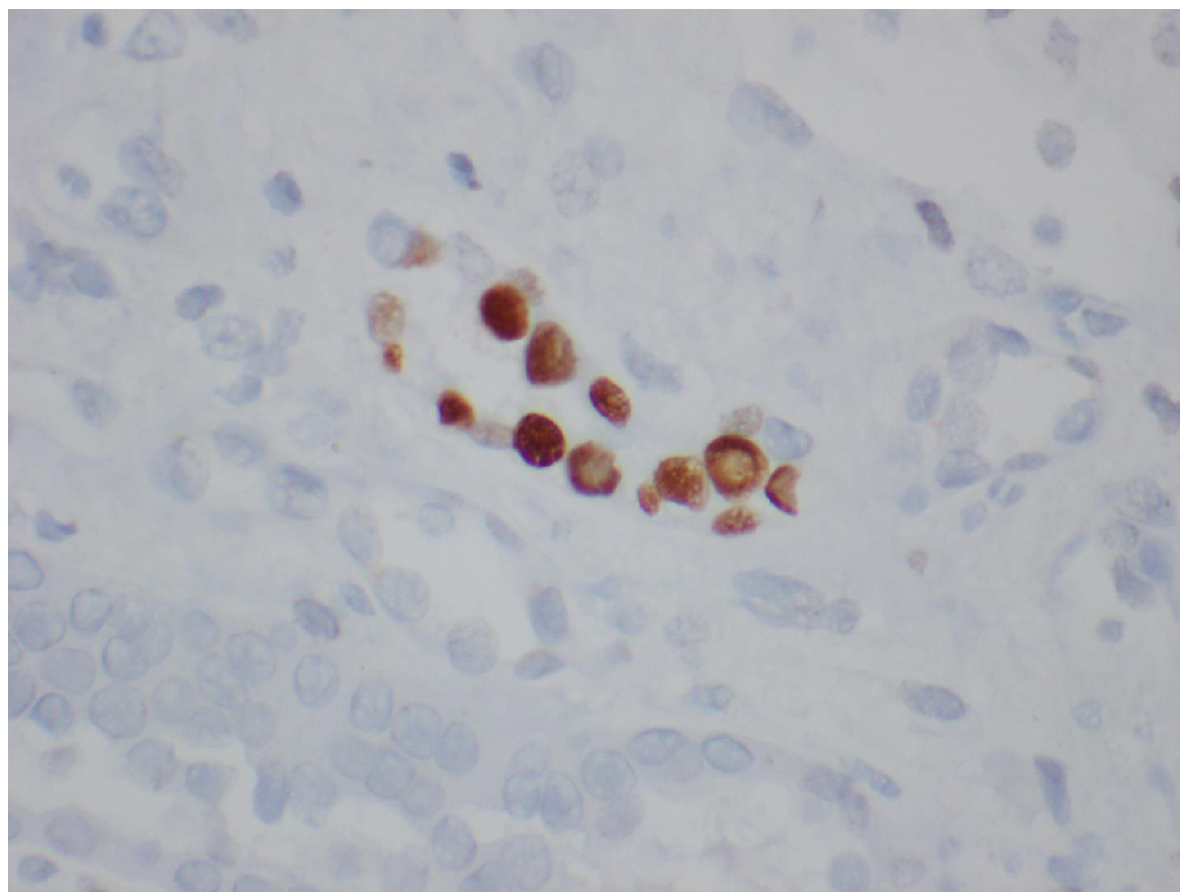
Figure 5. SV40 IHC staining highlighting infected tubular epithelial cells (600×).